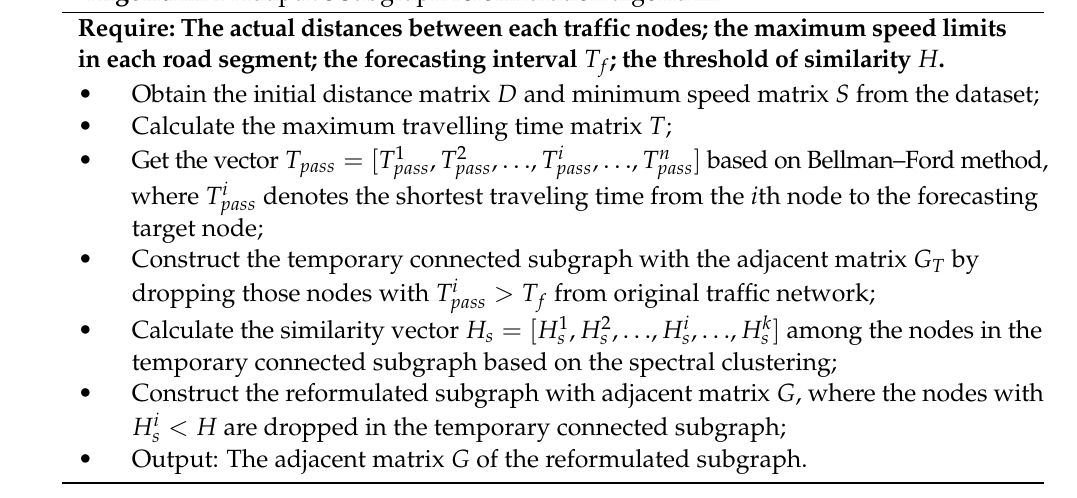
Algorithm 1 Adaptive subgraph reformulation algorithm